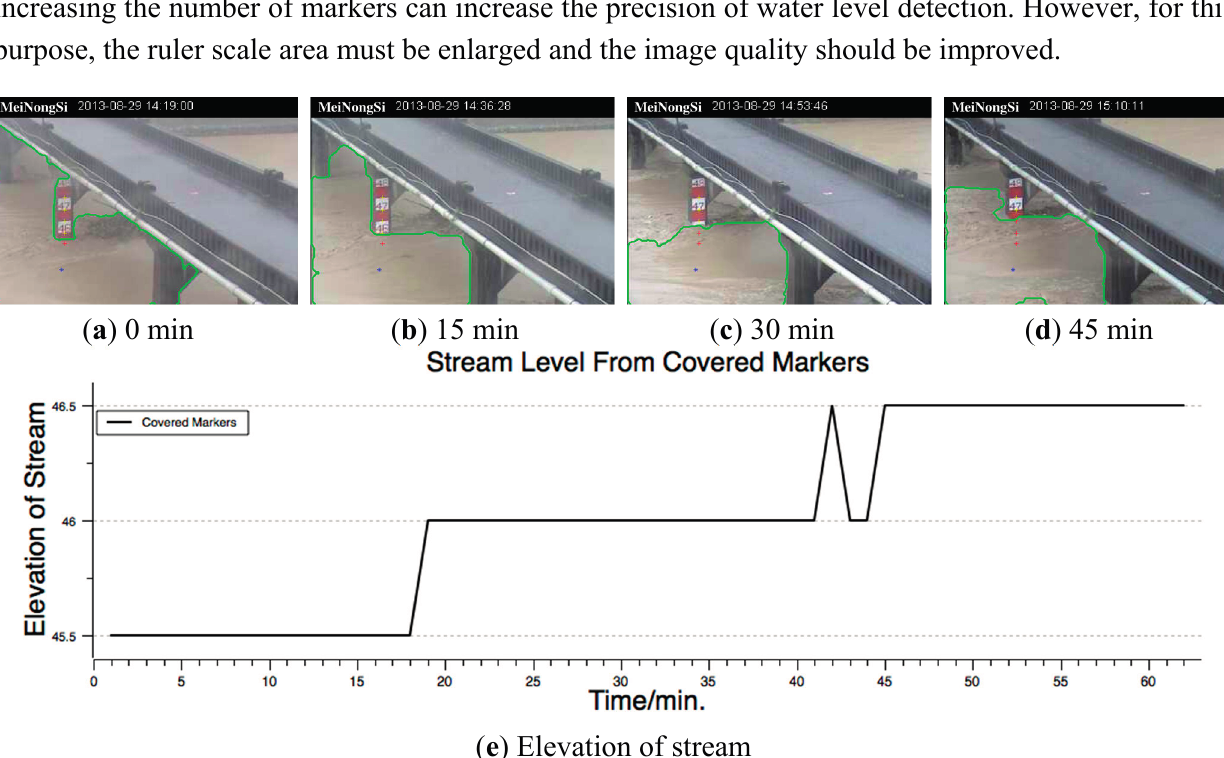
Figure 7. Indirect measurement of water level of runoff stream. The ruler scale in the images shows the elevation. ( a – d ) show the visual sensing results from screen shots every 15 min; and ( e ) the graph generated using the number of the virtual markers covered by the waterbody against